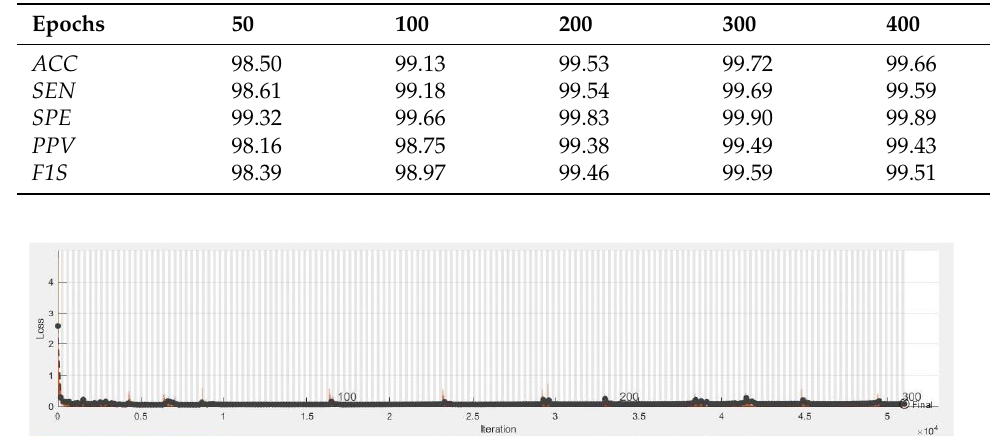
Table 5. Classification evaluation results with confusion matrix parameters and five different epochs (in unit %).